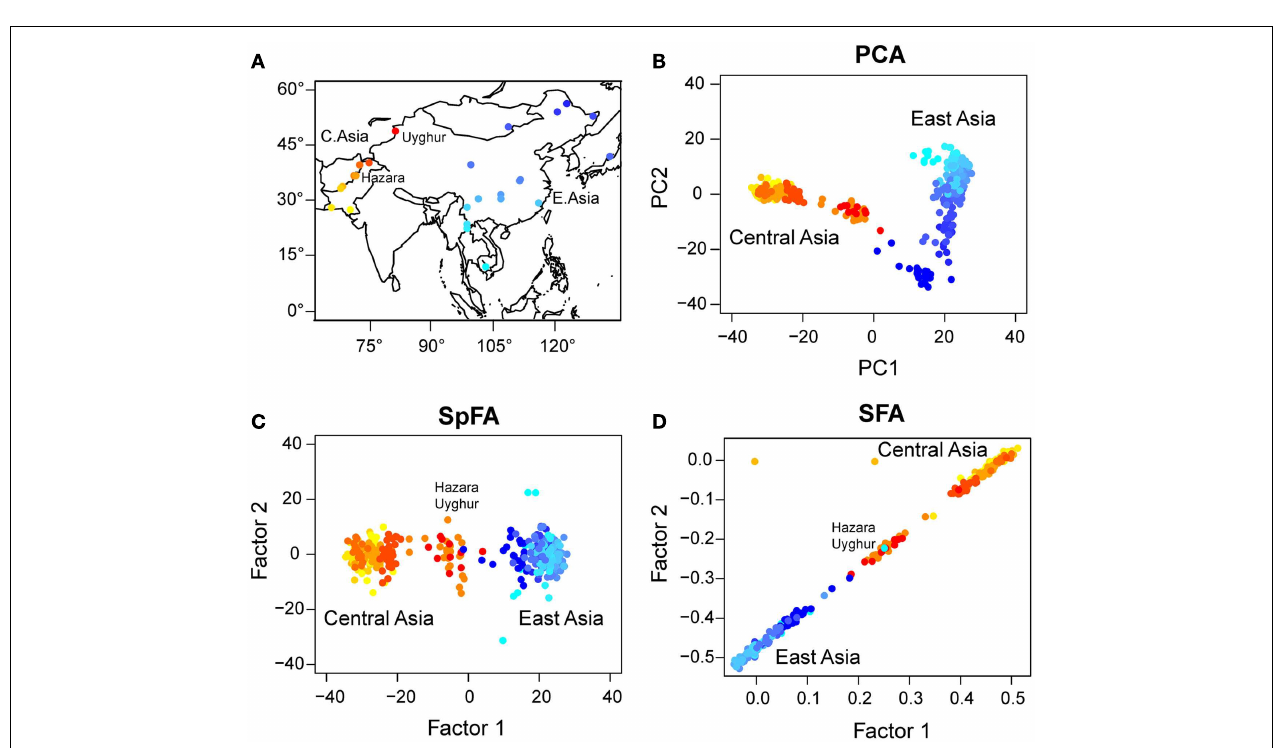
FIGURE 6 |Wilks’ (cid:51) statistic as a function of the divergence time, τ , ranging between 1 and 100.